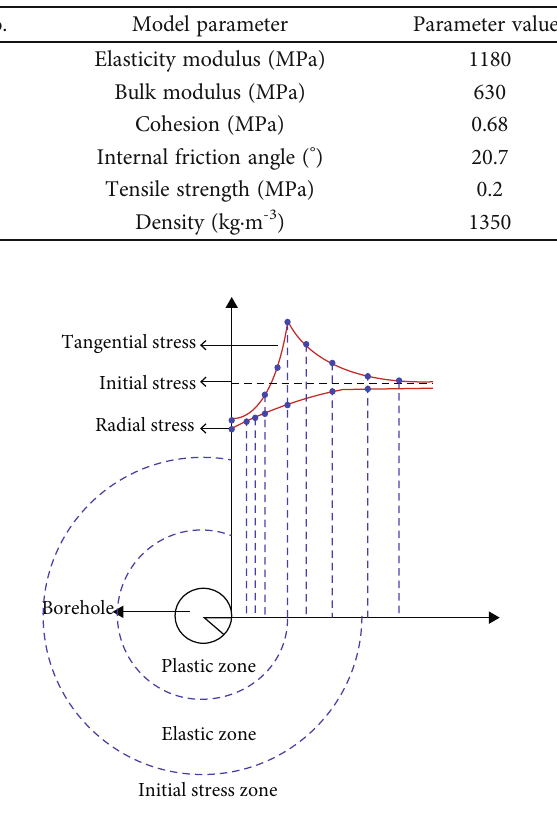
Table 1: Basic parameters of the coal seam.